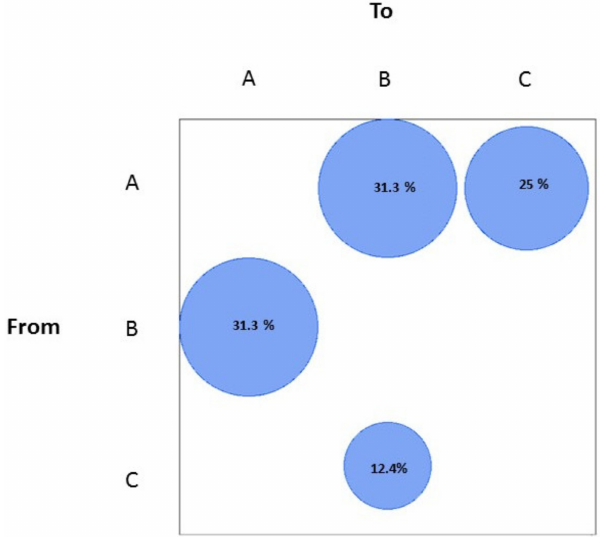
Figure 2. Maximum parsimony migration patterns of SARS-CoV-2 Italian genomes to/from different areas of the country (A, north; B, center; C, south). The bubblegram shows the frequency of gene flow (migrations) to/from different areas, as the percentage of total observed migrations estimated from the tree with a modified version of the Slatkin and Maddison test. Only statistically supported gene flows were reported. The surface of each circle is proportional to the percentage of observed migrations stated within the